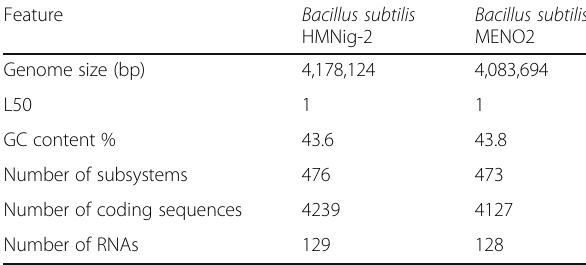
Table 1 General genomic features of Bacillus subtilis strains